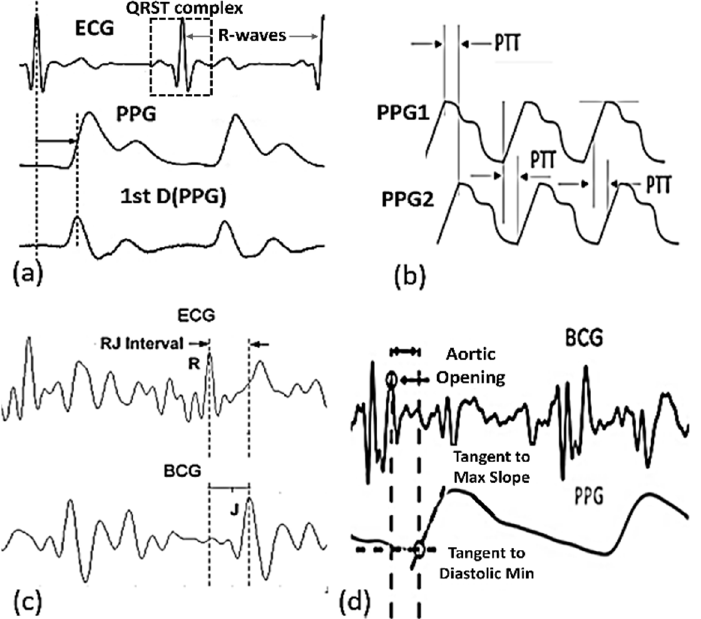
Figure 2. Methods for extracting PTT using combinations of biomedical signals: ( a ) using a combination of ECG and dPPG, ( b ) a combination of two PPGs, ( c ) a combination of ECG and BCG, and ( d ) a combination of BCG and PPG.